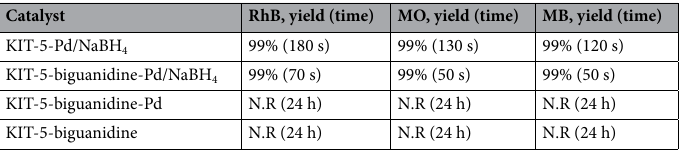
Table 3. The control experiments for the reduction of MO, MB and RhB.